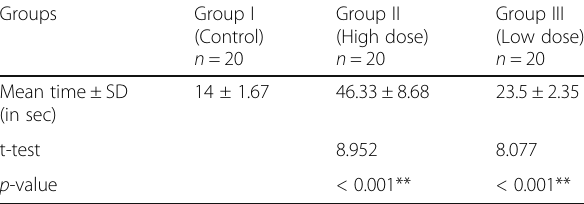
Table 2 The mean time taken by rats in each group in the rat maze to reach food in the maze arms using Student t test Groups